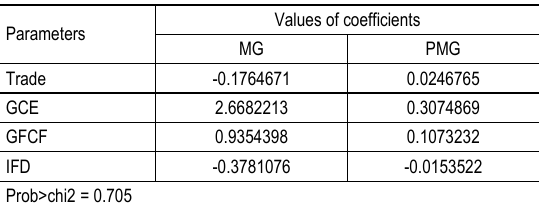
Table 12. The results of the Hausman test to